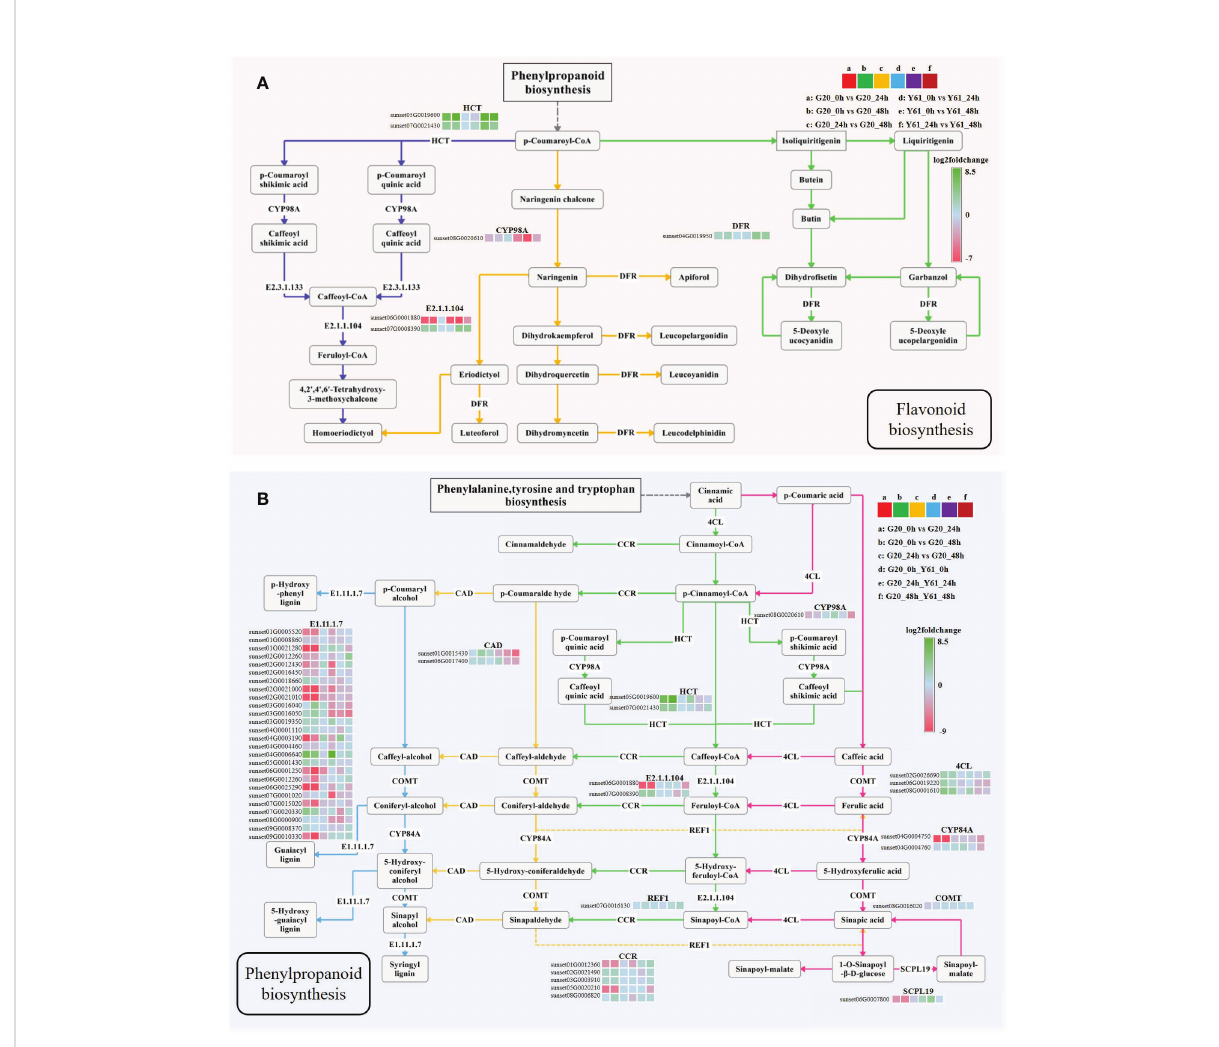
FIGURE 7 The expression patterns of differentially expressed genes in the fl avonoid (A) and phenylpropanoid biosynthesis (B) pathways. The fold-change is the ratio of the former group to the latter group. The enzymes involved are: shikimate O-hydroxycinnamoyltransferase (HCT), 5-O-(4- coumaroyl)-D-quinate 3 ’ -monooxygenase (CYP98A), caffeoyl-CoA O-methyltransferase (E2.1.1.104), bifunctional dihydro fl avonol 4-reductase/ fl avanone 4-reductase (DFR), peroxidase (E1.11.1.7), cinnamyl-alcohol dehydrogenase (CAD), coniferyl-aldehyde dehydrogenase (REF1), cinnamoyl-CoA reductase (CCR), 4-coumarate-CoA ligase (4CL), ferulate-5-hydroxylase (CYP84A), caffeic acid 3-O-methyltransferase/ acetylserotonin O-methyltransferase (COMT), and serine carboxypeptidase-like 19